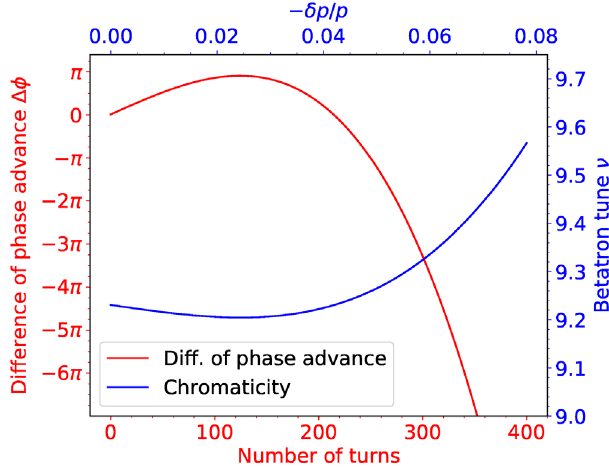
FIG. 5. Difference of the phase advances between high mo- mentum [ δ p=p ¼ þ 0 . 17% ( þ 2 σ )] and low momentum [ δ p=p ¼ − 0 . 17% ( − 2 σ )] particles (red curve, bottom and left axes) and the chromaticity for vertical motion (blue curve, top and right